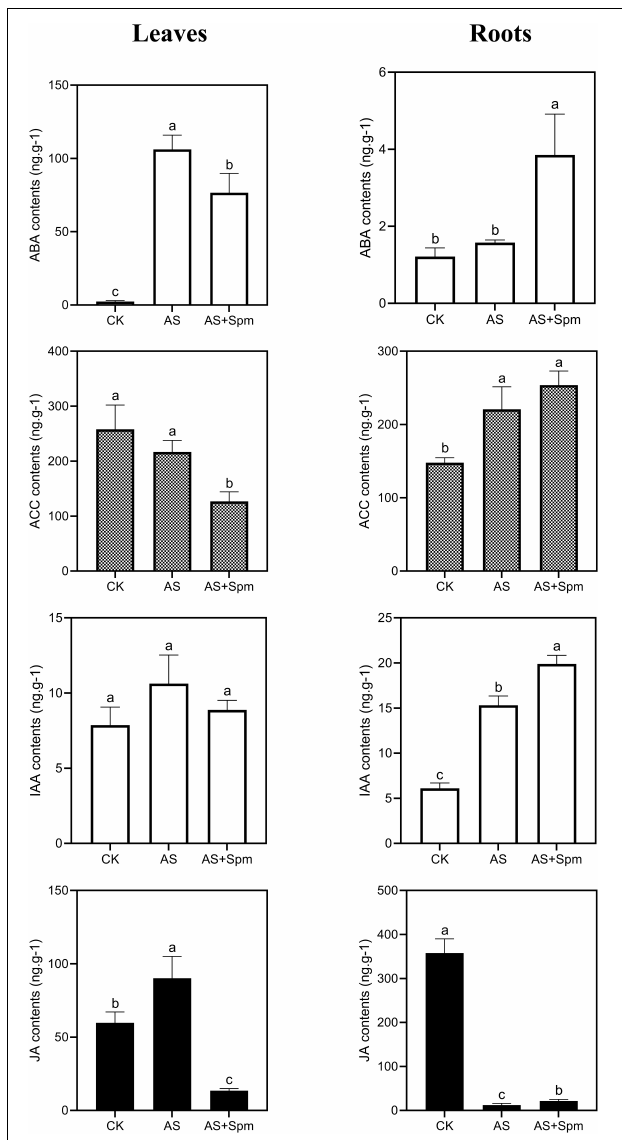
FIGURE 5 | Effects of spermine on ABA, ACC, IAA, JA contents under alkali stress. CK, control; AS, alkali stress (35 mmol.L − 1 Na 2 CO 3 :NaHCO 3 = 1:1); AS + Spm, alkali stress + spermine (35 mmol.L − 1 Na 2 CO 3 :NaHCO 3 + 0.01 mmol.L − 1